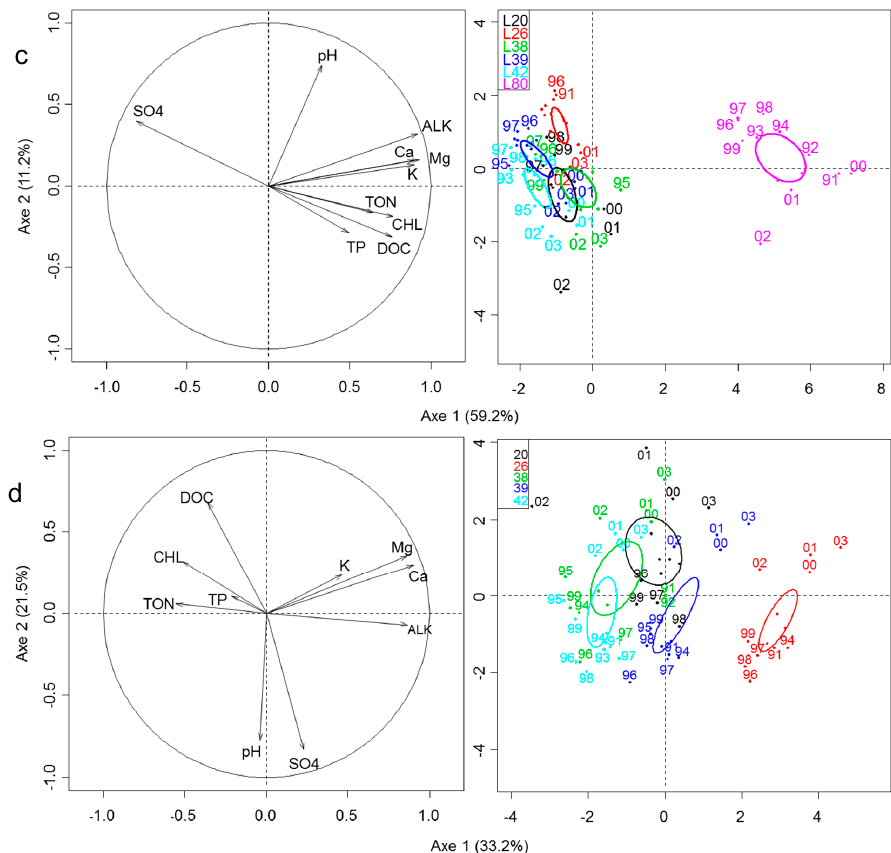
Figure 2. Biplot of the principal component analysis (PCA) based on correlations: ( a ) among climate variables measured from 1991 to 2003 ( n = 13), ( b ) among morphometric variables of the six monitored lakes ( n = 6), ( c ) among physical and chemical variables of the six monitored lakes from 1991 to 1999 ( n = 76), and ( d ) among physical and chemical variables in the monitored lakes (except L80) from 1991 to 1999 ( n = 63). L80 was deleted to represent more clearly the differences in water quality among interconnected undisturbed and disturbed lakes. For all left panels, arrows represent environmental variables within the correlation circle. Sites are represented on the right panel. Additionally, sites for climatic variables (panel a) are represented following a time constrained cluster analysis based on a multivariate regression tree analysis of the three climatic variables where two groups were found, as indicated by a solid line (1991–1998) and a dotted line (1999–2003). Confidence ellipses based on Lake are shown for physical and chemical variables in panel c.